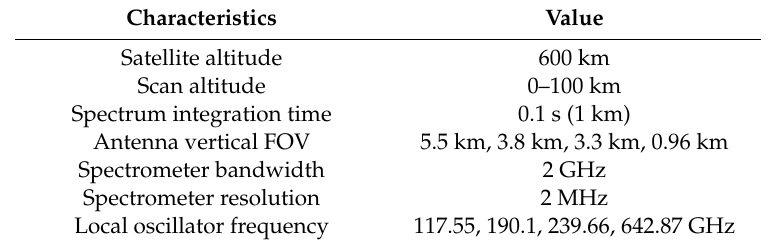
Table 1. The main observation characteristics of the THz Atmospheric Limb Sounder (TALIS).